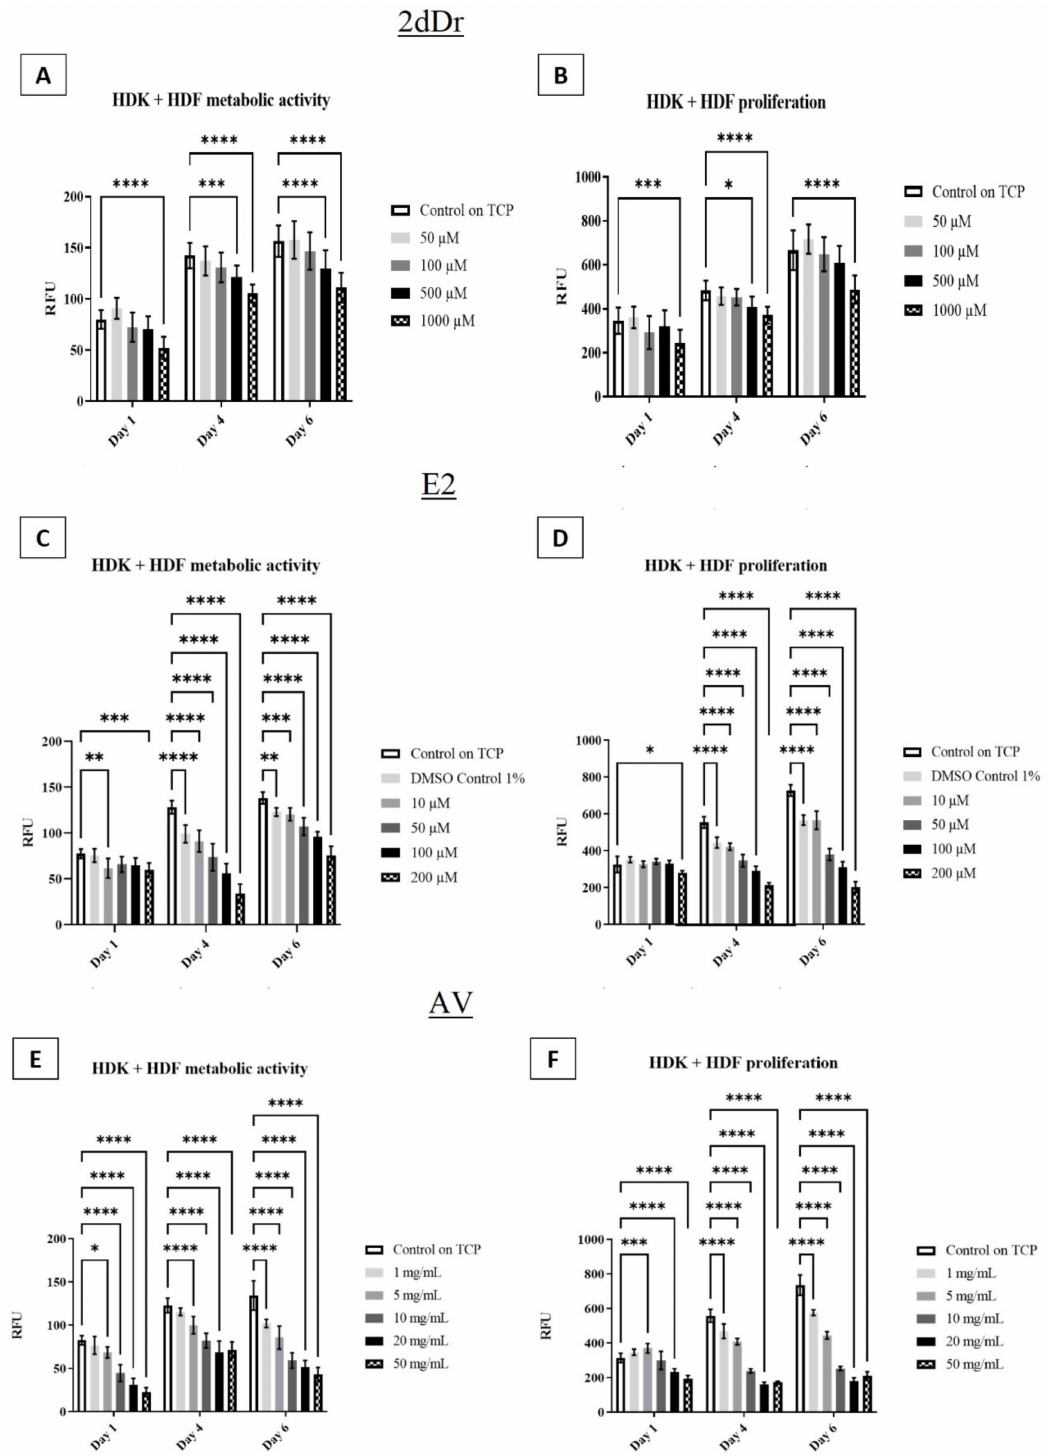
Figure 5. HDK + HDF metabolic activity and proliferation in the presence of solubilized 2dDr ( A , B ), E2 ( C , D ), and AV ( E , F ) at different concentrations. * p < 0.05, ** p < 0.01, *** p < 0.001, **** p < 0.0001. N = 3, n =